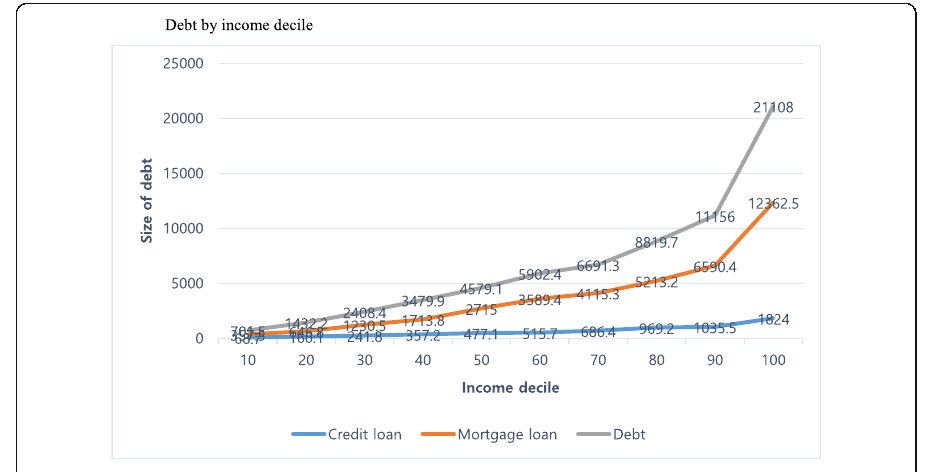
Fig. 3 Debt by income